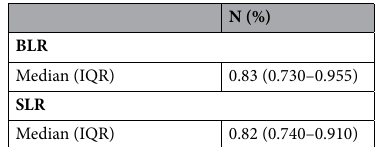
Table 1. Patients’ characteristics. ASA American Society of Anesthesiology, BMI body mass index, CEA carcinoembryonic antigen, LVI lymphovascular invasion, LN lymph node, MSI microsatellite instability,